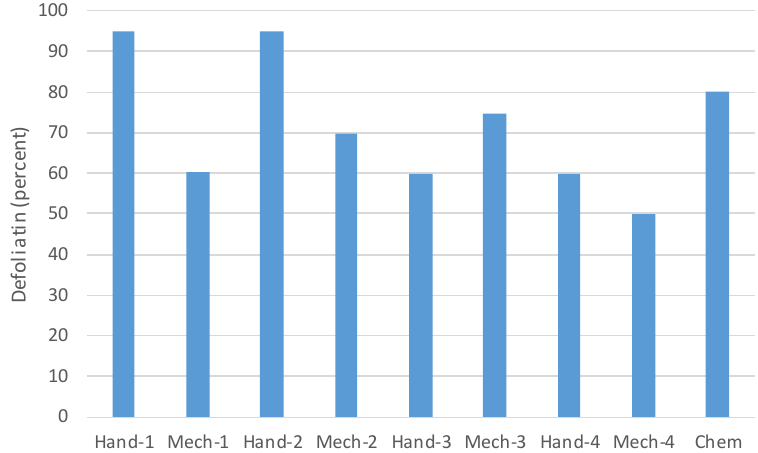
Figure 14. Defoliation estimation for field cotton grown under commercial practices common to deficit irrigated cotton in West Texas, United States. Note: the numeral following each treatment refers to which week they were treated by girdling along with the girdling method (hand knife, mechanical flap brush, chemical defoliation (control), flame girdling). Therefore, Hand ‐ 1 was treated the first week of October, Hand ‐ 2 during the second week and so on. Total growing time for all plants were identical. The only difference between type of treatment was duration from treatment to harvest. Hence, the time for Hand ‐ 1 plants from treatment until harvest was seven weeks. Hand ‐ 2 plants were treated a week later, so had six weeks from treatment until harvest.